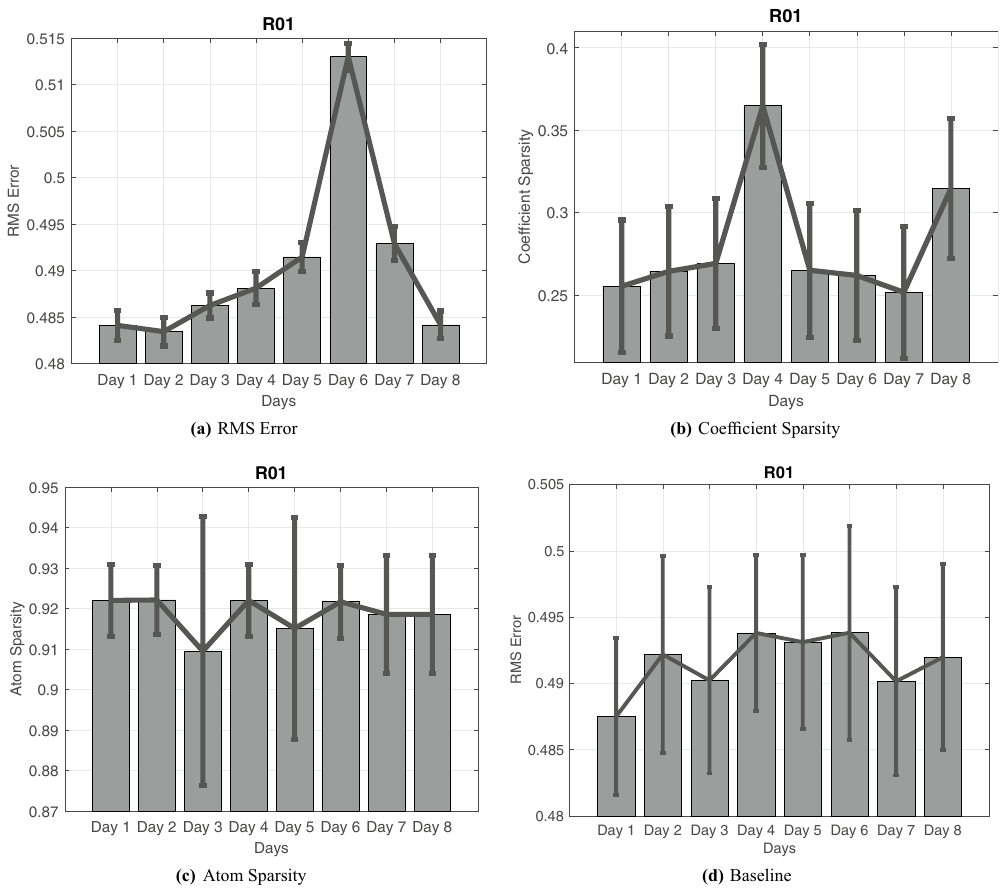
Figure 9. Reconstruction across 8 days (after learning only from data of day 1. Noise is 0.5 and the best 30 SRSSD dictionaries found on day 1 are used. Panel ( a ): RMS Error. Panel ( b ): coefficient sparsity. Panel ( c ) atom sparsity. Panel ( d ) Baseline performance: reconstruction of Phase 1. Note that Panel ( a ) shows an increase in the reconstruction error, until day 6 and then lower levels of the error in the next two days. The increase of reconstruction error across successive days is to be expected, given that the dictionary is acquired on day 1 (the high error value of day 6 may be due to specific characteristics of the corresponding maze). The decrease of error in the last two days may be due to stereotypy of behavior, specific characteristics of the corresponding mazes, or a combination of both